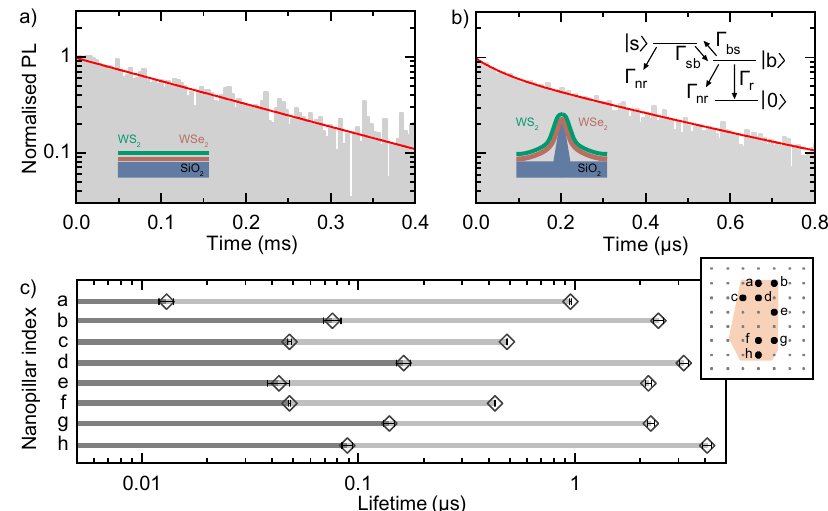
Fig. 4 Interlayer exciton lifetime. a Lifetime measurement of interlayer excitons in the fl at WS 2 /WSe 2 heterostructure region at 4 K. The data are fi tted by a single exponential (solid red curve) with a lifetime τ = 180.6± 3.5 μ s. b Lifetime measurement of a con fi ned interlayer exciton (1.39 eV emission peak from Fig. 3d). The solid red curve is a biexponential fi t with two lifetimes τ s = 59.4 ± 0.9 ns and τ l = 389.1 ± 1.2 ns. The inset presents a three-level model with coupling between a bright state b j i and a shelving state s j i , as discussed in Supplementary Note S8. c τ s (dark grey bars) and τ l (light grey bars) values extracted from biexponential fi ts to the lifetime measurements at the eight nanopillar locations in device A (indexed a – h). Error bars are fi tting errors. The average value of τ s ( τ l ) across all nanopillars is 80 ns (2 μ s). The inset maps the physical location of the nanopillars on the WS 2 /WSe 2 heterostructure region. The reduction of lifetime for con fi ned interlayer excitons as compared to delocalised is also seen in device B, see Supplementary Figs. S15d and